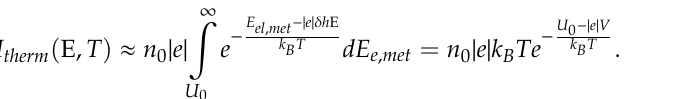
Figure 5. Dependence of relative tunneling current on the BNNS layer thickness with different e ffective potential amplitudes.